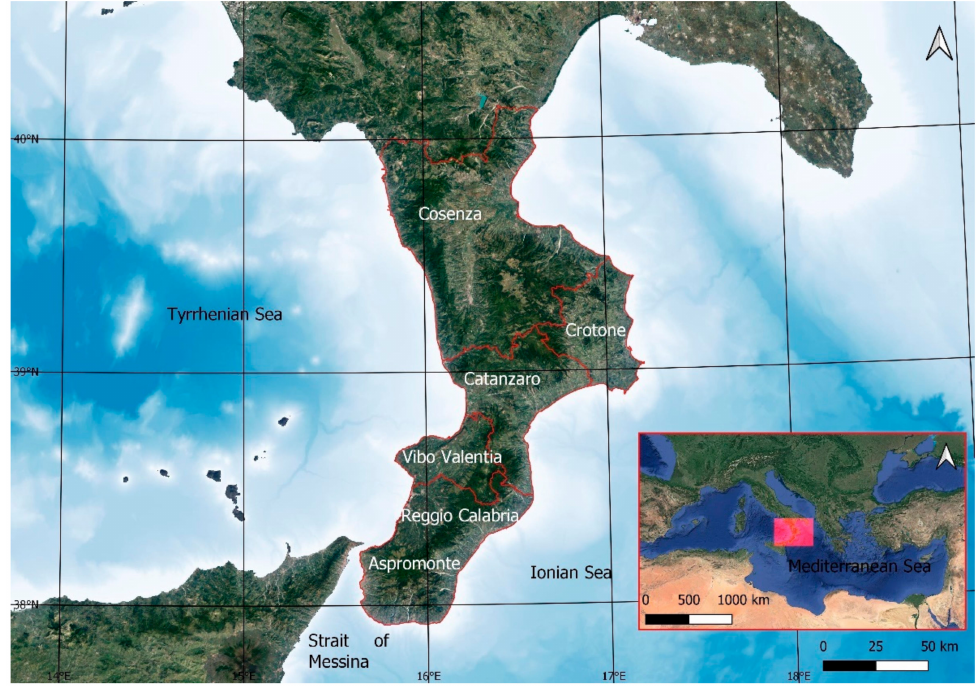
Figure 1. The Calabria region and its provinces (large panel). The geographical position of the Calabria region in the center of the Mediterranean Sea (small